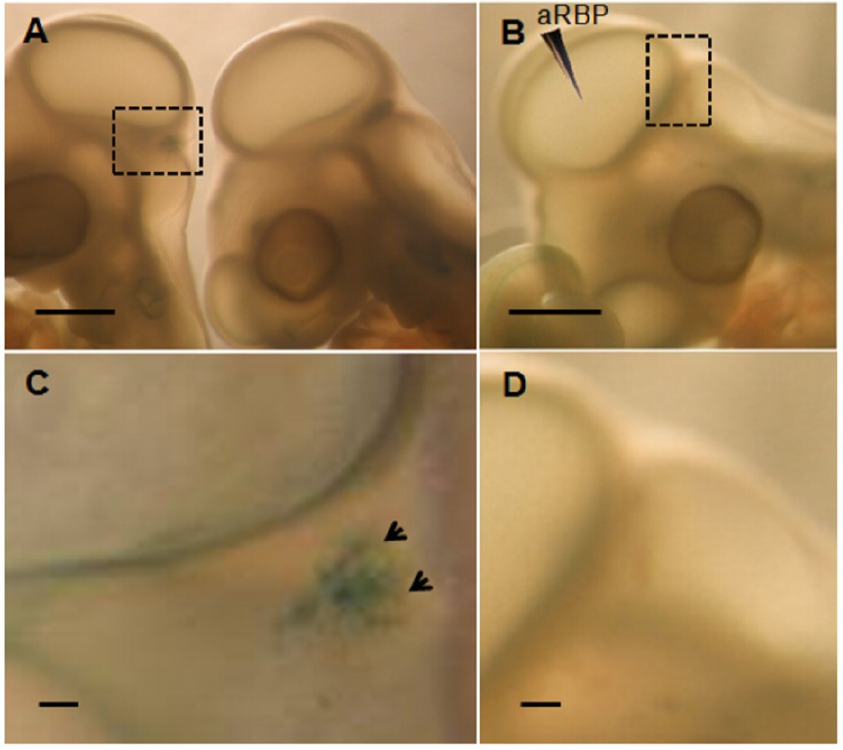
Figure 2. Photomicrographs of 23 H.H. stage chick embryos after microinjection of F9-1.8 cells in the mesencephalic-rombencephalic furrow delimited by a discontinuous line box in ( A ) and ( B ). After 24 h close to the IsO, the F9-1.8 microinjected cells develop a blue color (arrow heads in ( A ) and ( C )) showing Retinoic Acid activity in this tissue. ( C ) and ( D ) show embryos with a similar experimental approach but with a simultaneous microinjection of Retinol Binding Protein antibody into the brain cavity. Note that the F9-1.8 cells do not develop a blue color, suggesting the blocking of retinoic acid binding activity in the area (scale bar in ( A ) and ( B ): 1 mm; scale bar in ( C ) and ( D ): 100 